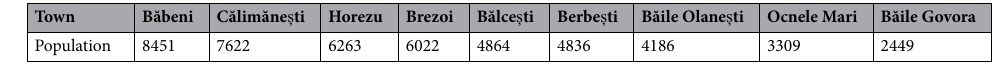
Table 2. Towns MICI and their number of populations in Vâlcea County